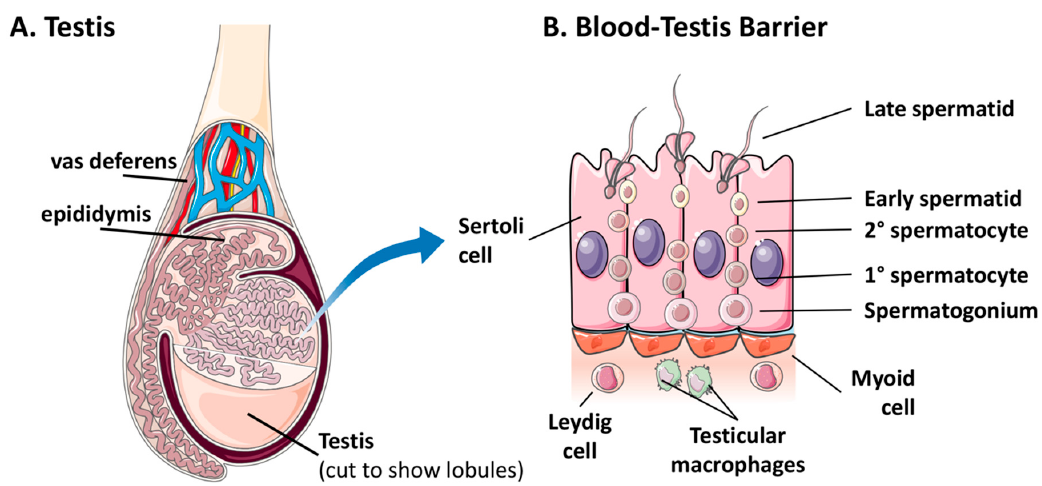
Figure 1. Localization of the blood-testis barrier within the male reproductive tract. ( A ) Localization of the seminiferous tubule within the testis; ( B ) Cell composition and structure of the blood-testis barrier and contribution of surrounding cells to the barrier function and homeostasis. Tissue and cell images were derived and/or modified from Servier Medical Art under a Creative Commons Attribution